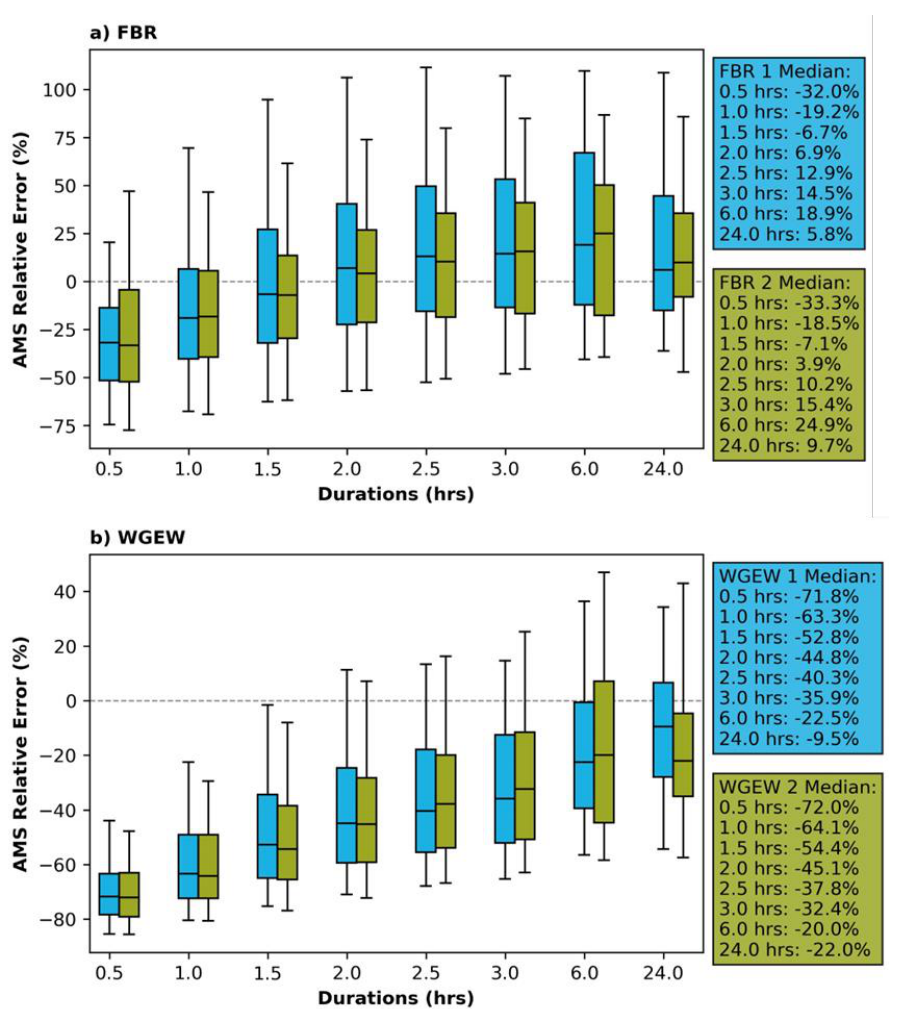
Figure 10. Percent relative error of precipitation AMS from IMERG compared with the gauge-based cells over FBR ( a ) and WGEW ( b ). The lower whiskers are located at the 5th percentile and the upper whiskers at the 95th percentile.